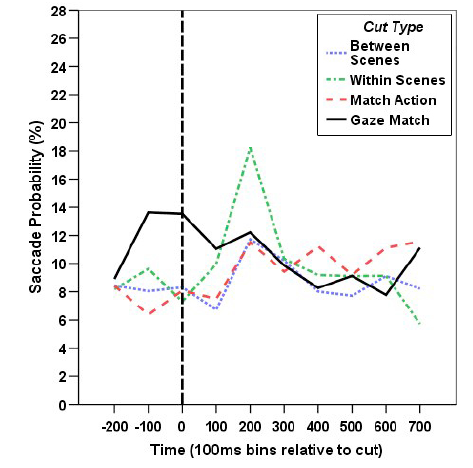
Figure 2: Saccade probability in 100ms bins before and after the cut across the four cut